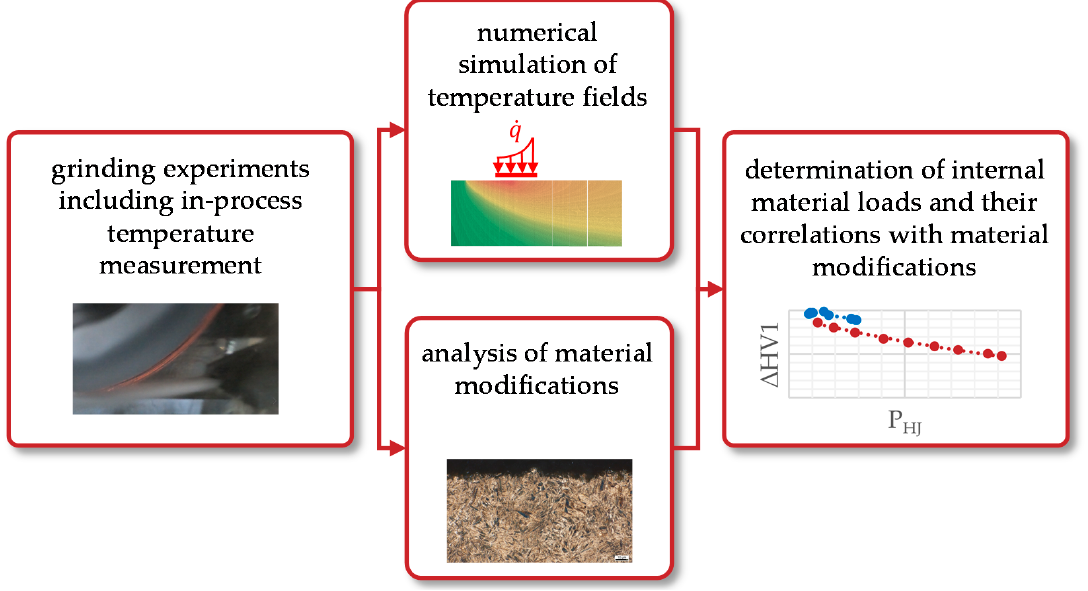
Figure 2. Procedure and expected outcome.